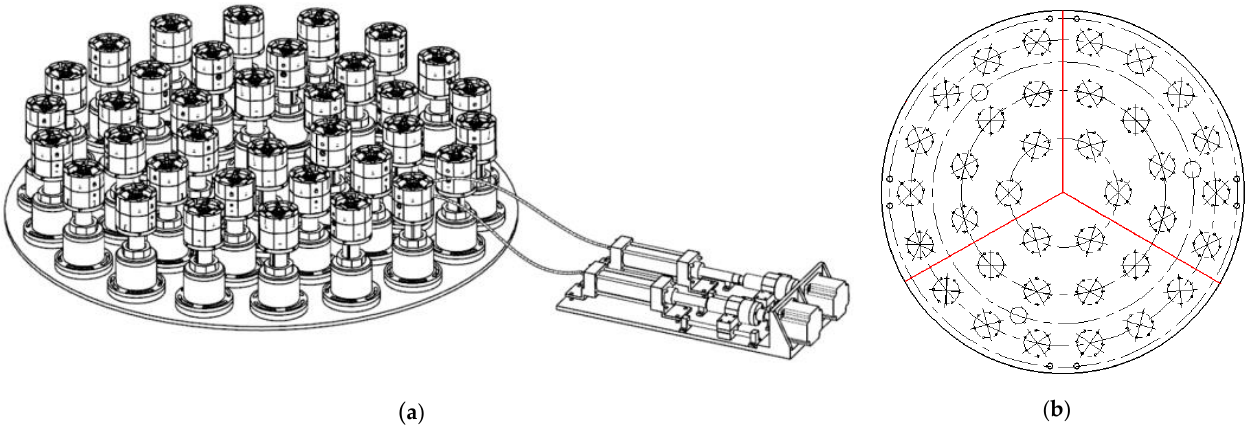
Figure 1. Model of the flexible support system (FSS). ( a ) 3D model of the FSS. ( b ) Arrangement of support cylinder.